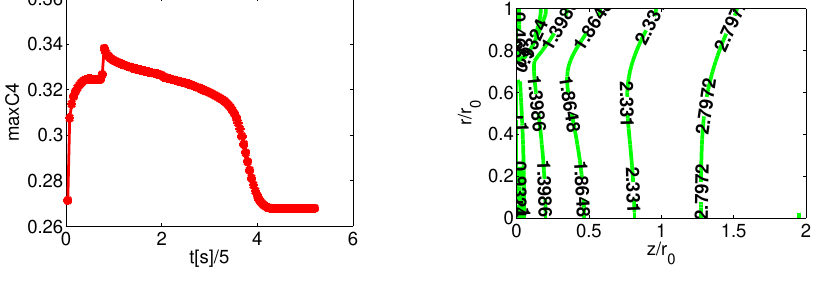
Figure 15. Maximum concentration of CO 2 vs. t at t f =5.1.